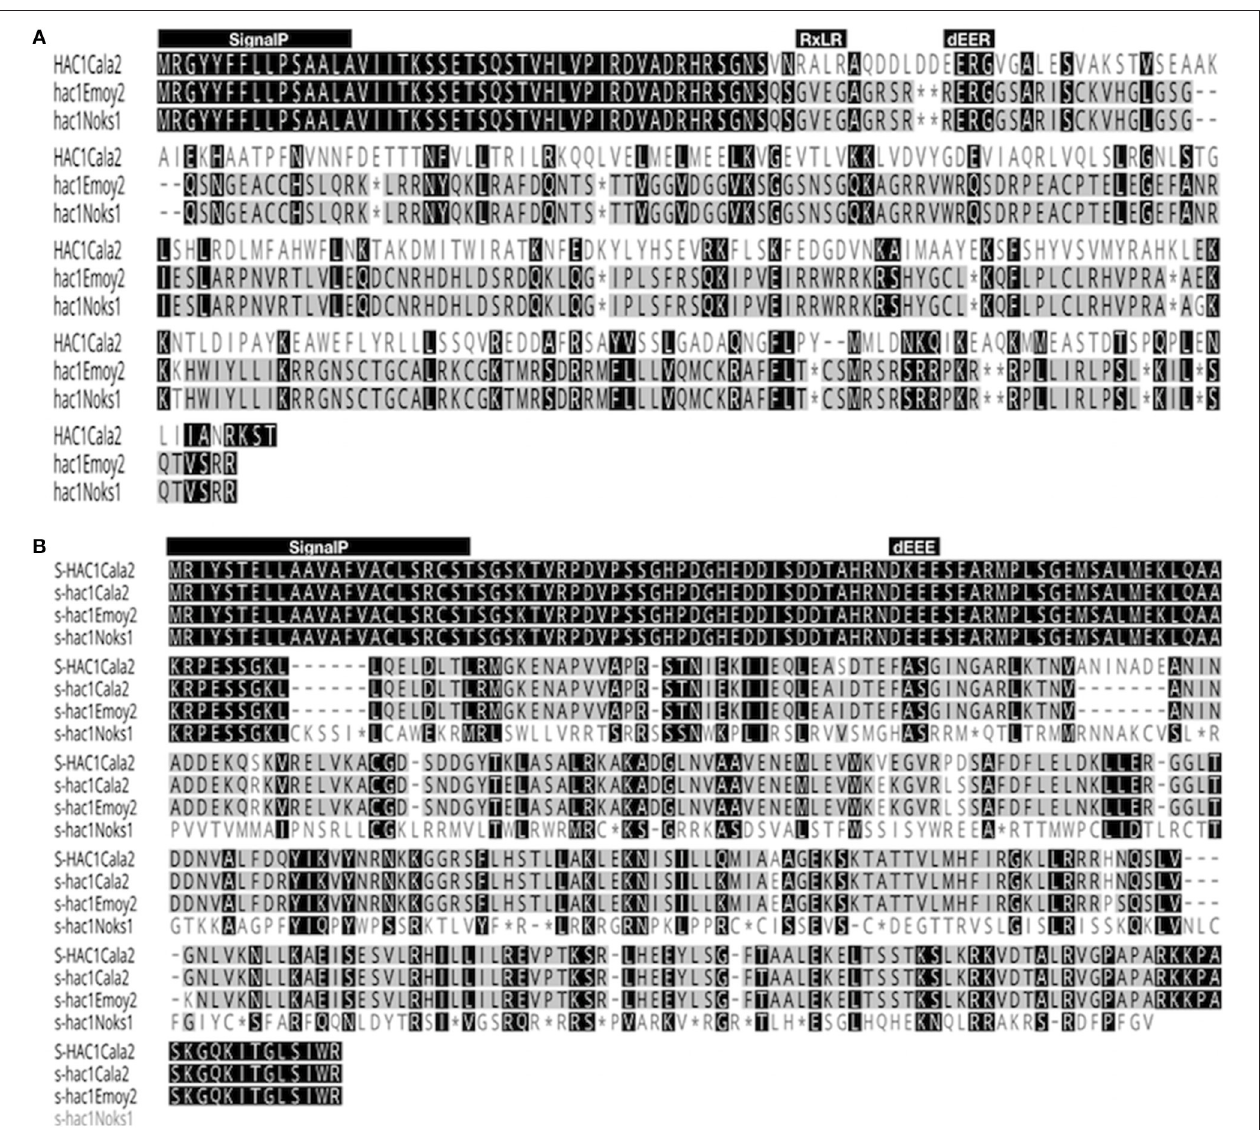
FIGURE 6 | Alignment of amino acid sequences of HAC1 and S-HAC1. Amino acid sequences of HAC1 and S-HAC1 were predicted from cDNAs isolated from Hpa -Cala2, Hpa -Noks1 and Hpa -Emoy2 and were aligned using Geneious (v8.0). (A) Alignment of HAC1 Cala2 , HAC1 Noks1 , and HAC1 Emoy2 amino acid sequences. Black or dark gray boxes with white letters indicate identity or similarity, respectively, to HAC1 Cala2 and dashes indicate gaps in the alignment. The reading frames are adjusted to fit translation of regions downstream of stop codon. The predicted N-terminal signal peptide, the RXLR and dEER motifs are shown above the sequences, (B) Alignment of amino acid sequences of S-HAC1 Cala2 , s-hac1 Cala2 , s-hac1 Noks1 and s-hac1 Emoy2 . Black or dark gray boxes with white letters indicate identity or similarity, respectively, to S-HAC1 Cala2 and dashes indicate gaps in the alignment. The predicted N-terminal signal peptide and the dEER motifs are shown above the sequences. *indicates stop